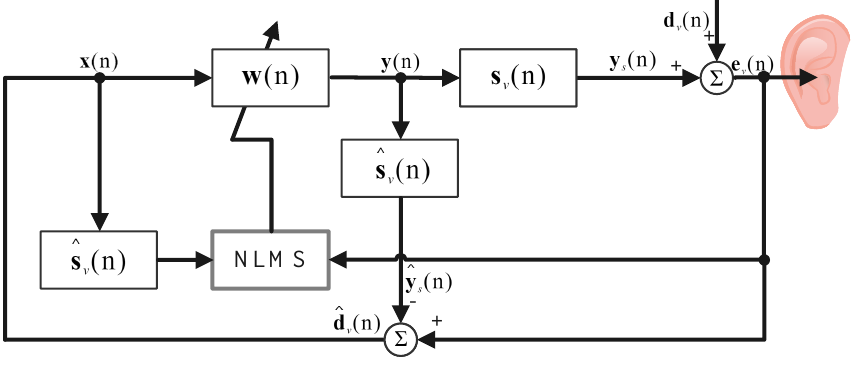
Figure 2. Block diagram of the multichannel feedback FxNLMS